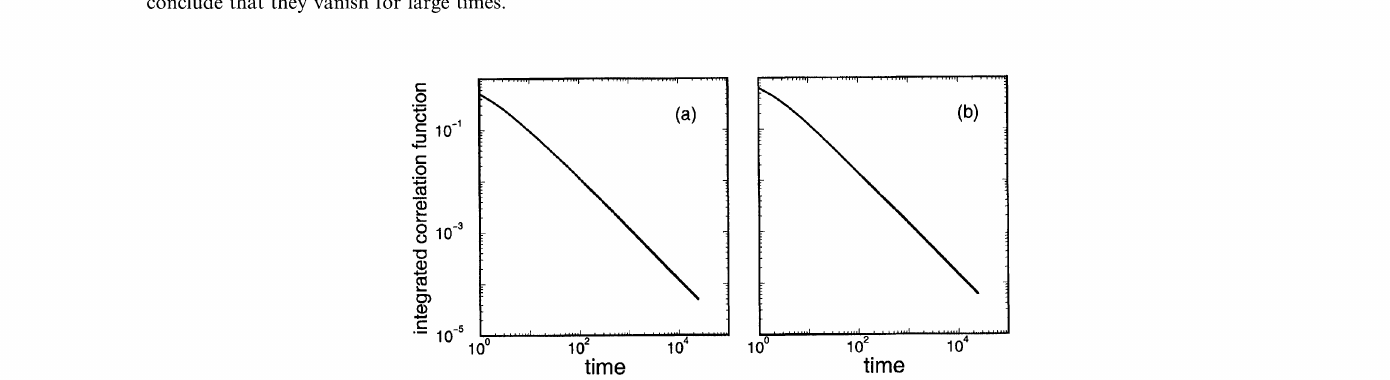
FIGURE 11 Integrated correlation functions (9): (a) the correlation function of the variable xl (Fig. 10a); (b): The correlations of the symbolic sequence of two symbols, as described in